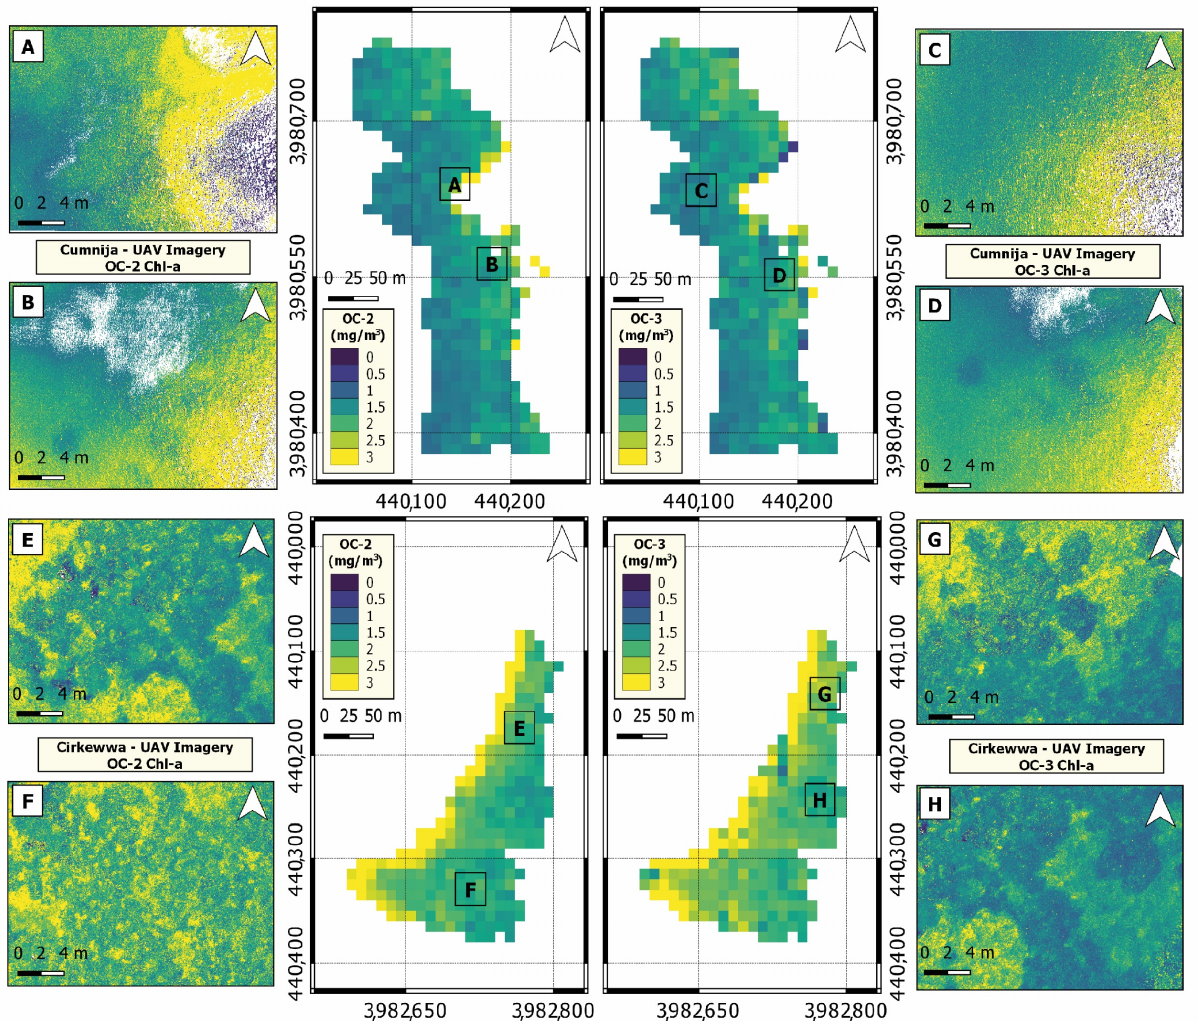
Figure 7. Spatial distribution of Chl-a for Ċ umnija and Cirkewwa using OC-2 [31] and OC-3 [32] algorithms. S2L2 Chl-a maps are represented in the middle of the figure, and subplots ( A – H ) refer to zoomed Chl-a UAV data at each study location.